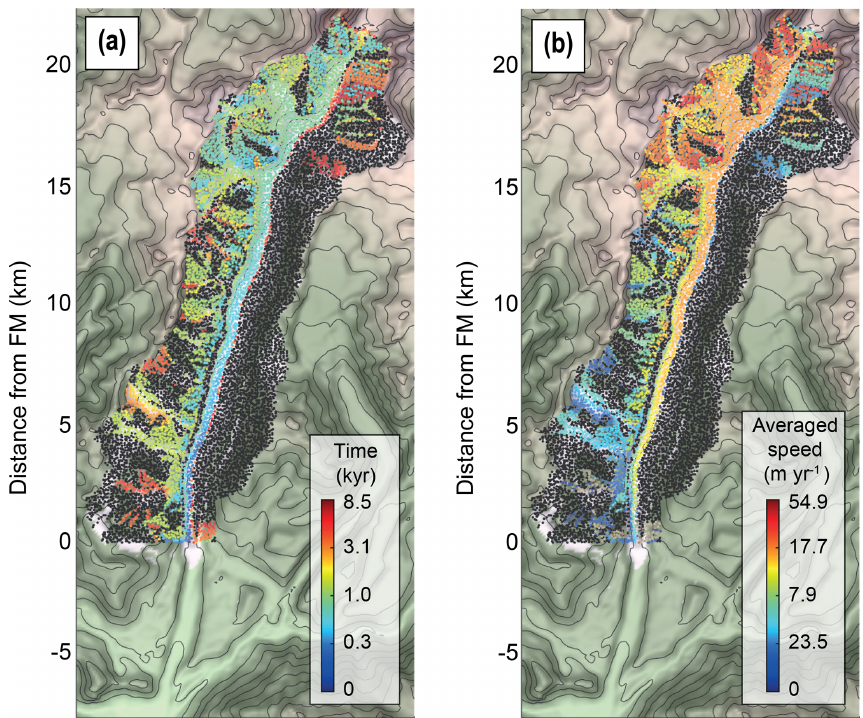
Figure 10. Characteristics of particle transfer to the frontal moraine: (a) the time needed for each particle to reach the frontal moraine and (b) their averaged speed. Black dots are particles that did not reach the frontal moraine